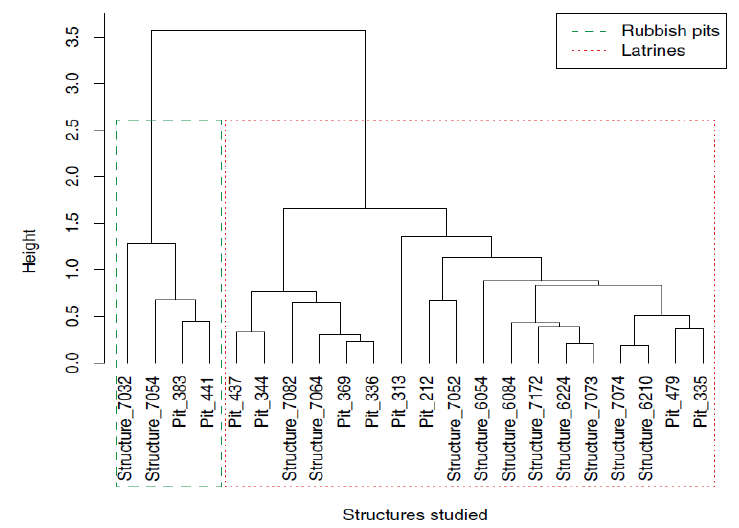
Figure 2. Example of hierarchical cluster analysis of structures from the site of Horbourg-Wihr. The group formed by rubbish pits is delimited by a green dashed line and that of the latrines by a red dotted line.